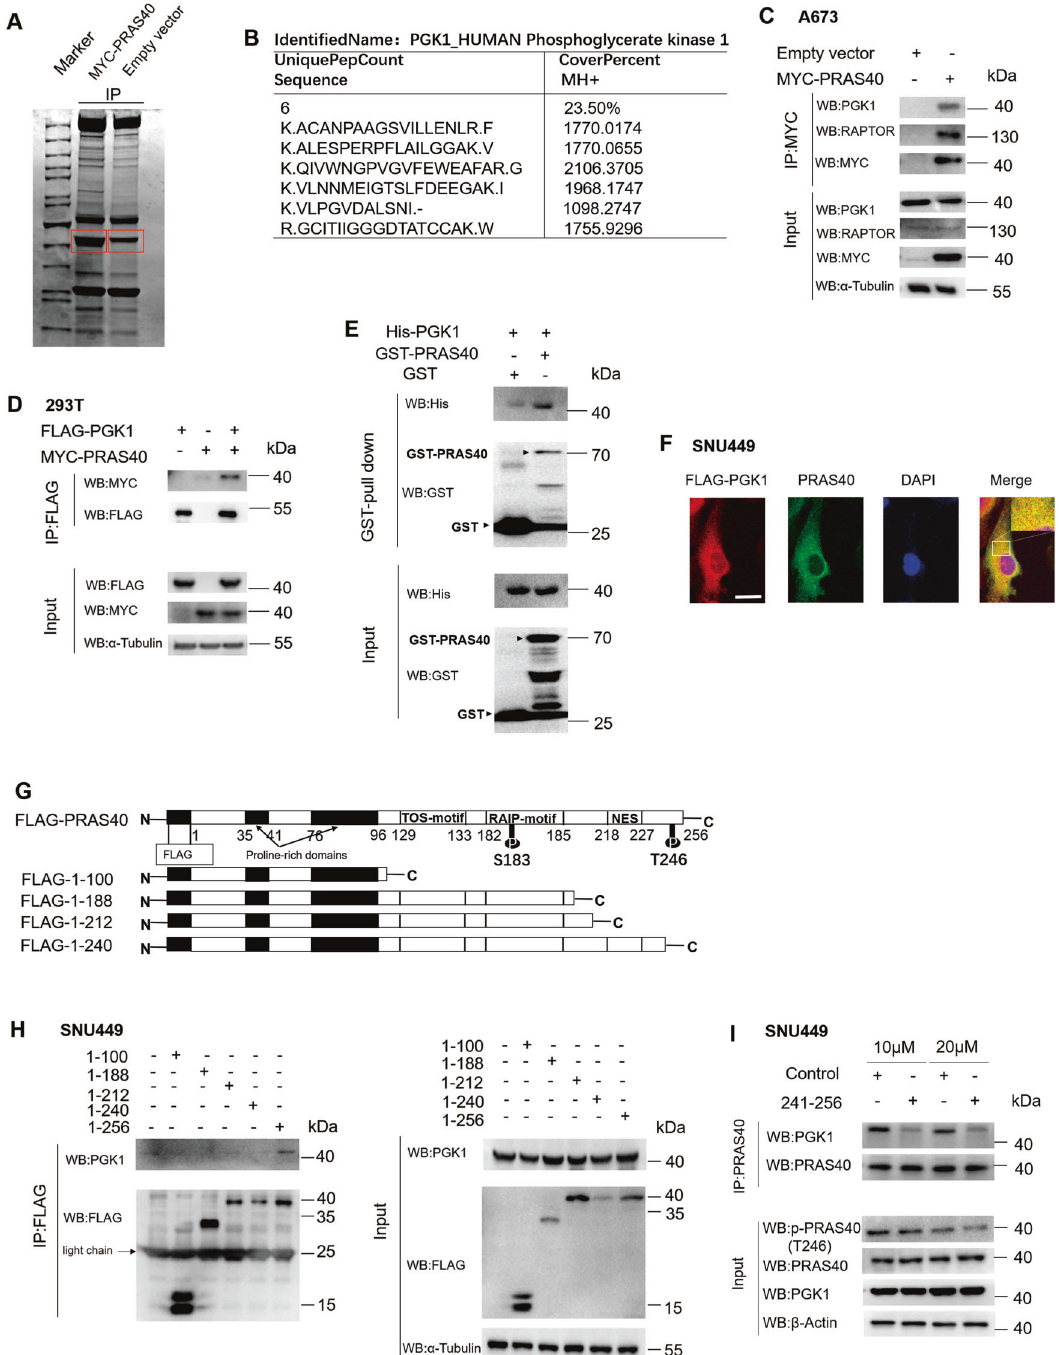
Fig. 1 Interaction between PRAS40 and PGK1. A – C Co-IP with anti-Myc antibody. The bands with red boxes were cut out and applied to mass spectrometry ( A ). The unique peptides of PGK1 enriched in Myc-PRAS40-bound precipitates were clari fi ed by mass spectrometric analyses ( B ). Western Blotting analyses using the indicated antibodies ( C ). D Co-IP followed by western blotting analyses with anti-FLAG antibody. E GST pull-down assay using GST or GST-PRAS40 together with His-PGK1. F Immuno fl uorescent staining with anti-FLAG and anti- PRAS40 antibodies in the cells introduced with FLAG-PGK1. Scale bar, 10 μ m. G Schematic diagram showing the deletion mutants of PRAS40. H, I Co-IP followed by western blotting analyses with the indicated antibodies in the indicated cells. The cells were treated with peptide control or peptide 241 – 256 at the indicated concentrations I + Myc-PRAS40 T246A group, and the tumor volume and weight tumor formed in PGK1-knockdown group ( P < 0.01). When the were downregulated greatly compared to that of the shPGK1 PGK1-knockdown cells reintroduced with PRAS40-expression + Myc-PRAS40 group ( P < 0.05), but not different from that of the vector were injected, four tumors formed ( n = 4 in Fig. 3G-J; PGK1-knockdown group (Fig. 3K, L). In addition, similar to the n = 6 in Fig. 3K, L), and the tumor volume and weight were partly results in vitro, PRAS40 phosphorylation was downregulated restored ( P < 0.05). However, only two tumors formed in shPGK1